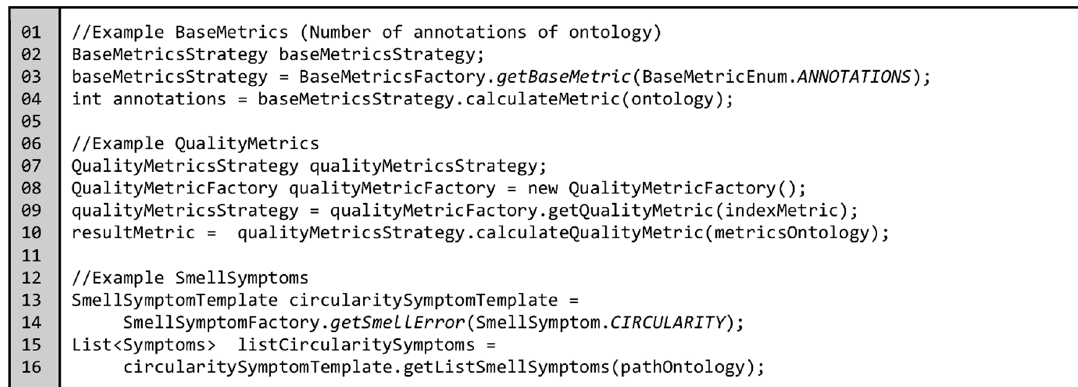
Figure 6. Example of using different kinds of metrics from the package OntoMetrics.